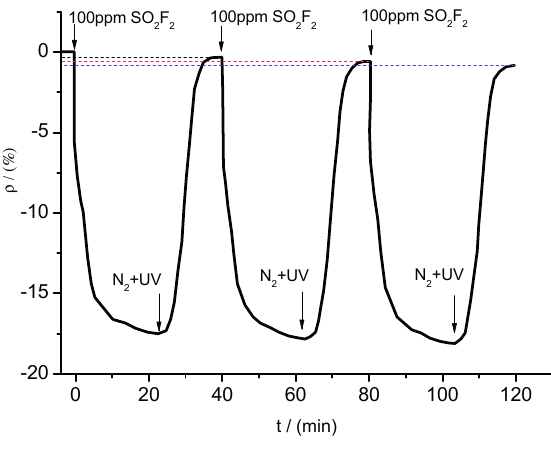
Figure 17. Response and recovery